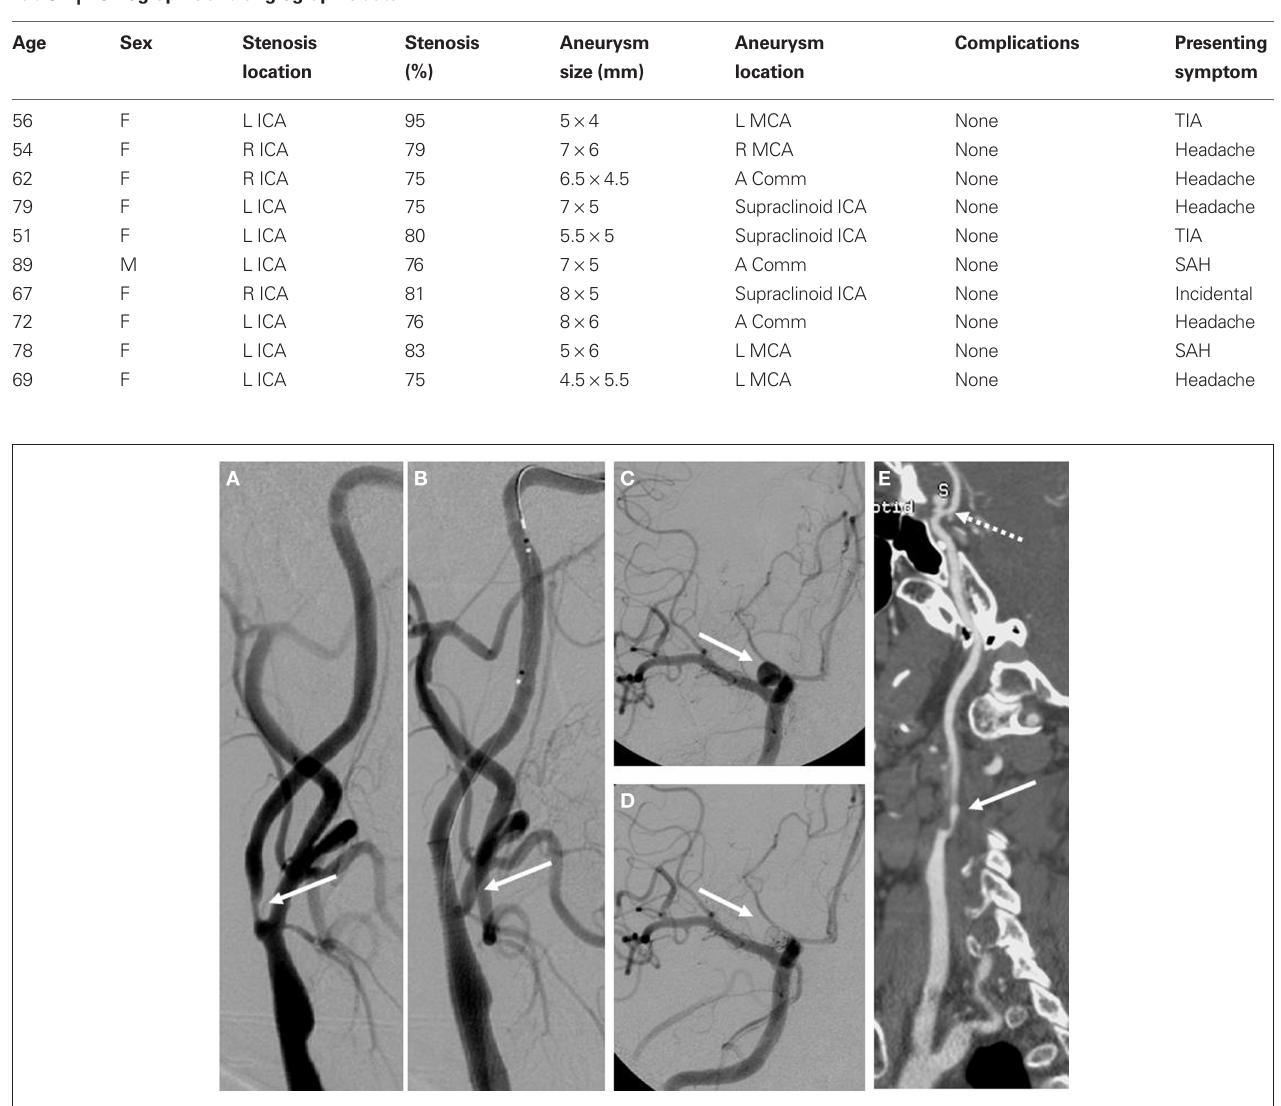
Figure 1 | Digital subtraction angiography of pre and post treatment internal carotid arteries is seen in (A,B) respectively. Pre and post treatment aneurysms are seen in the same arterial tree in (C,D) . A digitally reconstructed CT angiogram demonstrated the carotid atherosclerotic disease (solid arrow) and the unsecured aneurysm (dashed arrow) distal to it in (e)